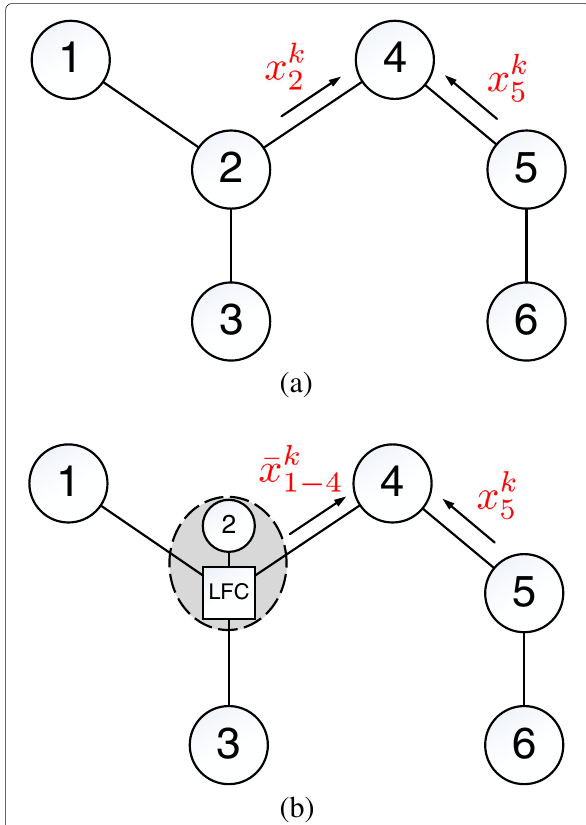
Fig. 3 A demonstration of in-network acceleration applied to the problem of example 1. The shaded dashed circle in ( b ) is equivalent to node 2 in ( a ), except that a virtual FC (square LFC) is created logically, making it amenable to the application of H-CADMM. The interface to other nodes remains the same. The information exchanged through the edges changes. For example, the message sent from nodes 2 to 4 changes from x k 2 , which describes only the state of node 2, to (cid:3) 4 k x k 1 − 4 = 1 / N n which contains information about 4 nodes n = 1 x